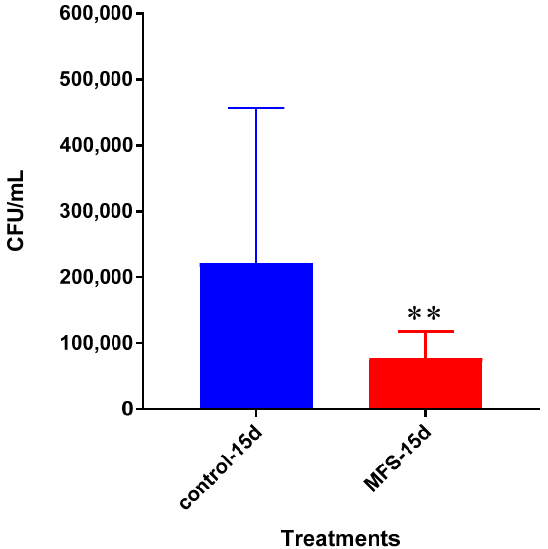
Figure 7. Survival of Mtb Erdman inside untreated and MFS-treated granulomas from healthy subjects. Data represent means ± SE from eight healthy individuals. ** p < 0.005 when comparing samples at 15 days.